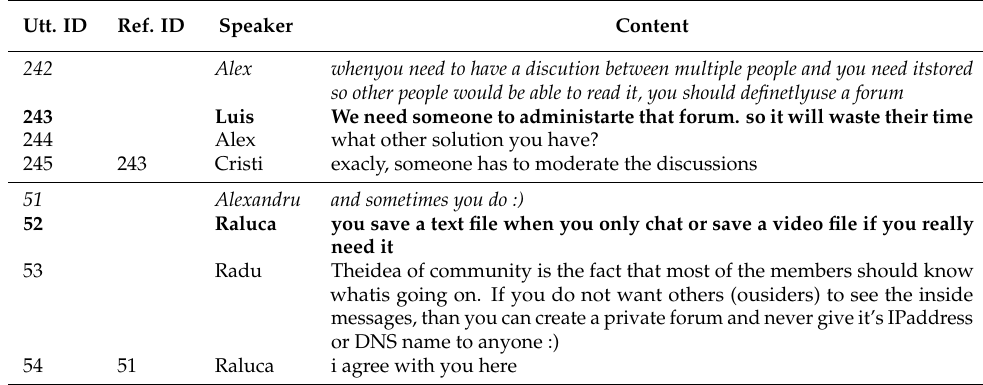
Table 11. Second example of wrong semantic link prediction ( explicit link / predicted link ).